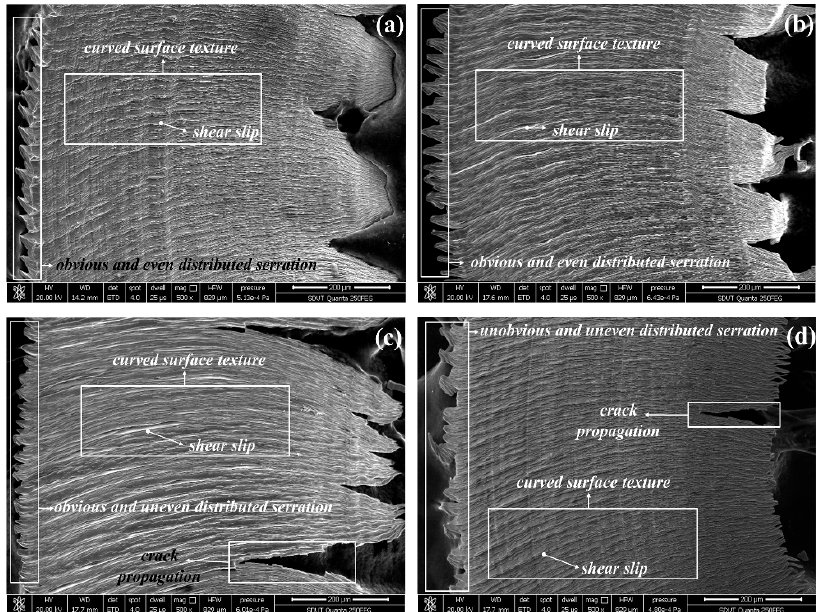
Figure 3. Micrographs of chip surfaces away from the rake face at v c = 360 m/min, f z = 0.04 mm/z, a p = 0.4 mm, and a e = 4 mm, ( a ) TiN / TiCN / TiAlN multi-coating, ( b ) AlTiN coating, ( c ) TiAlN + TiN composite coating, and ( d ) TiCN + NbC composite coating.